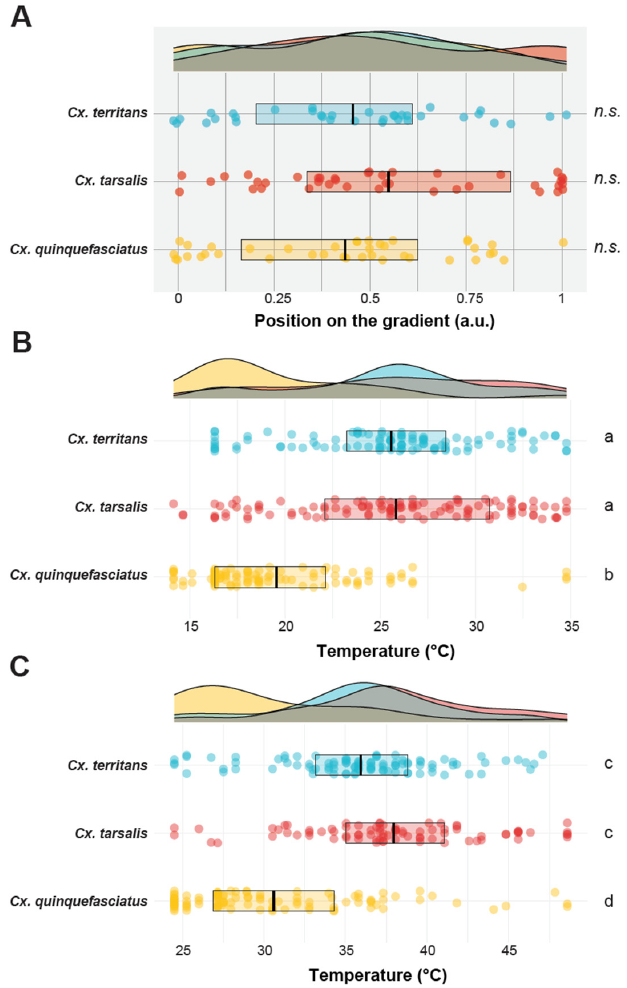
Figure 3. Thermopreference in Culex mosquitoes. ( A ). Mosquito distribution (bottom) on the alu- minum plate set at 25 ◦ C (i.e., constant temperature, control) and corresponding density plot (top). ( B ). Mosquito distribution (bottom) on the low temperature gradient (bottom) and corresponding density plot (top). ( C ). Mosquito distribution (bottom) on the high temperature gradient (bottom) and corresponding density plot (top). The density plots summarize the mosquitoes’ distribution along the gradient. Each dot represents the final resting position (i.e., T p ) of a single female mosquito. The boxes represent the upper and lower quartiles, and the black bars indicate the mean of each